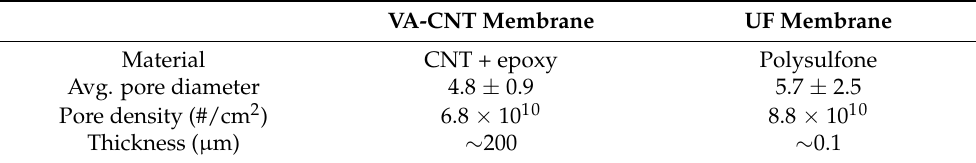
Table 2. Comparison between VA-CNT-based membrane and UF membrane (Reproduced with permission from Elsevier; adapted from Baek et al., 2014